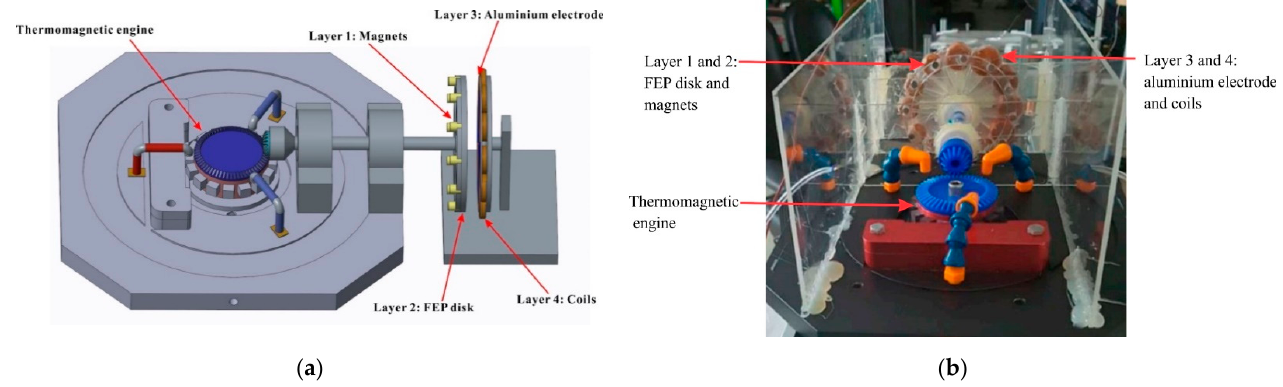
Figure 6. Schematic ( a ) and fabricated model ( b ) of hybridized TENG and EMG generator.